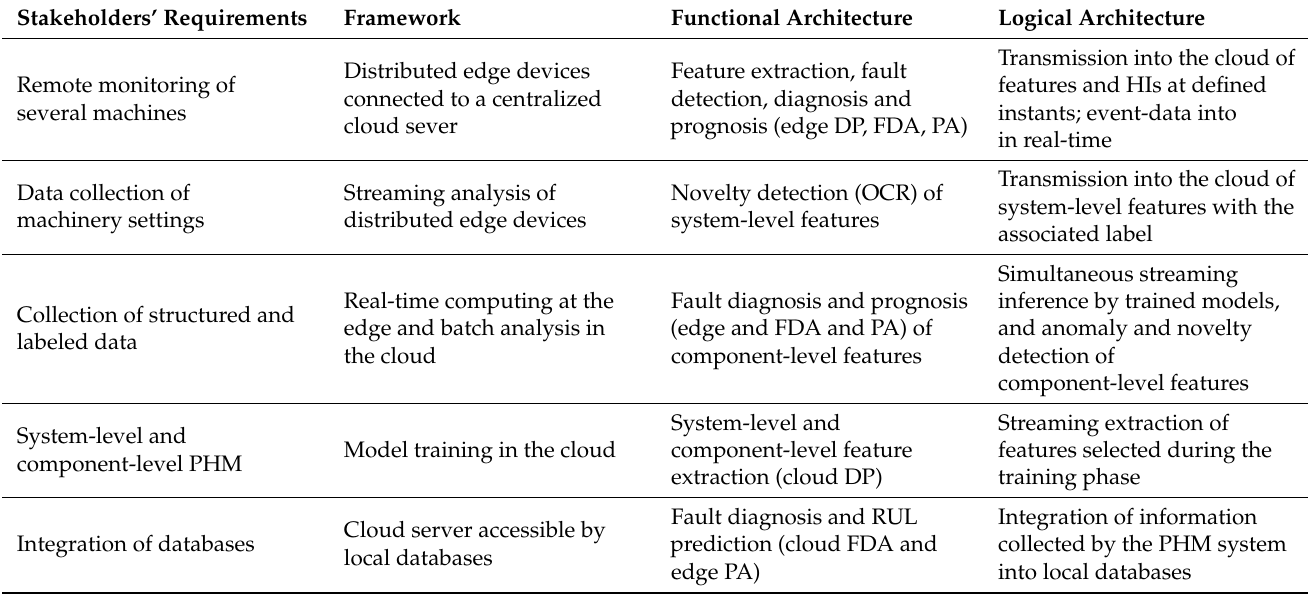
Table 1. Framework and architecture connections with stakeholders’ requirements.